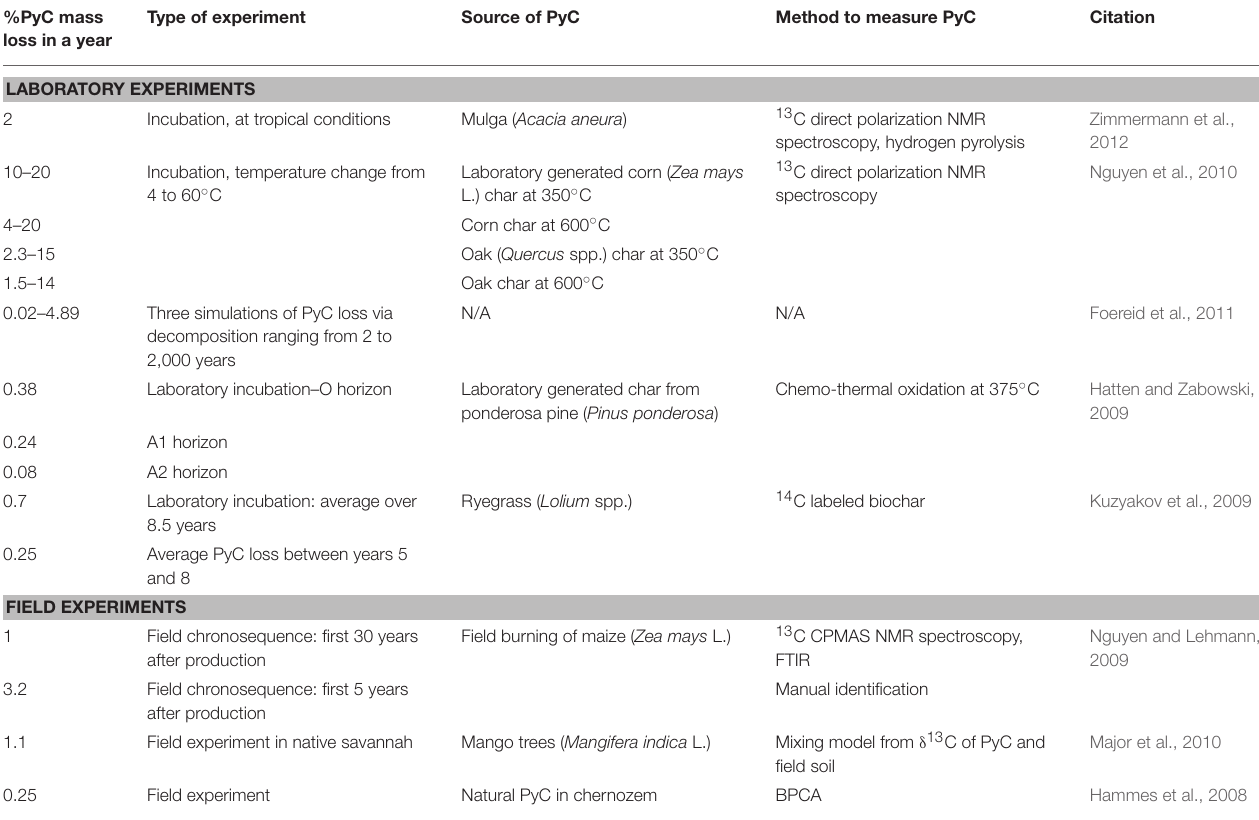
TABLE 1 | Examples of decomposition rates measured in laboratory and field studies, as converted to percent mass loss of PyC per year. %PyC mass loss in a